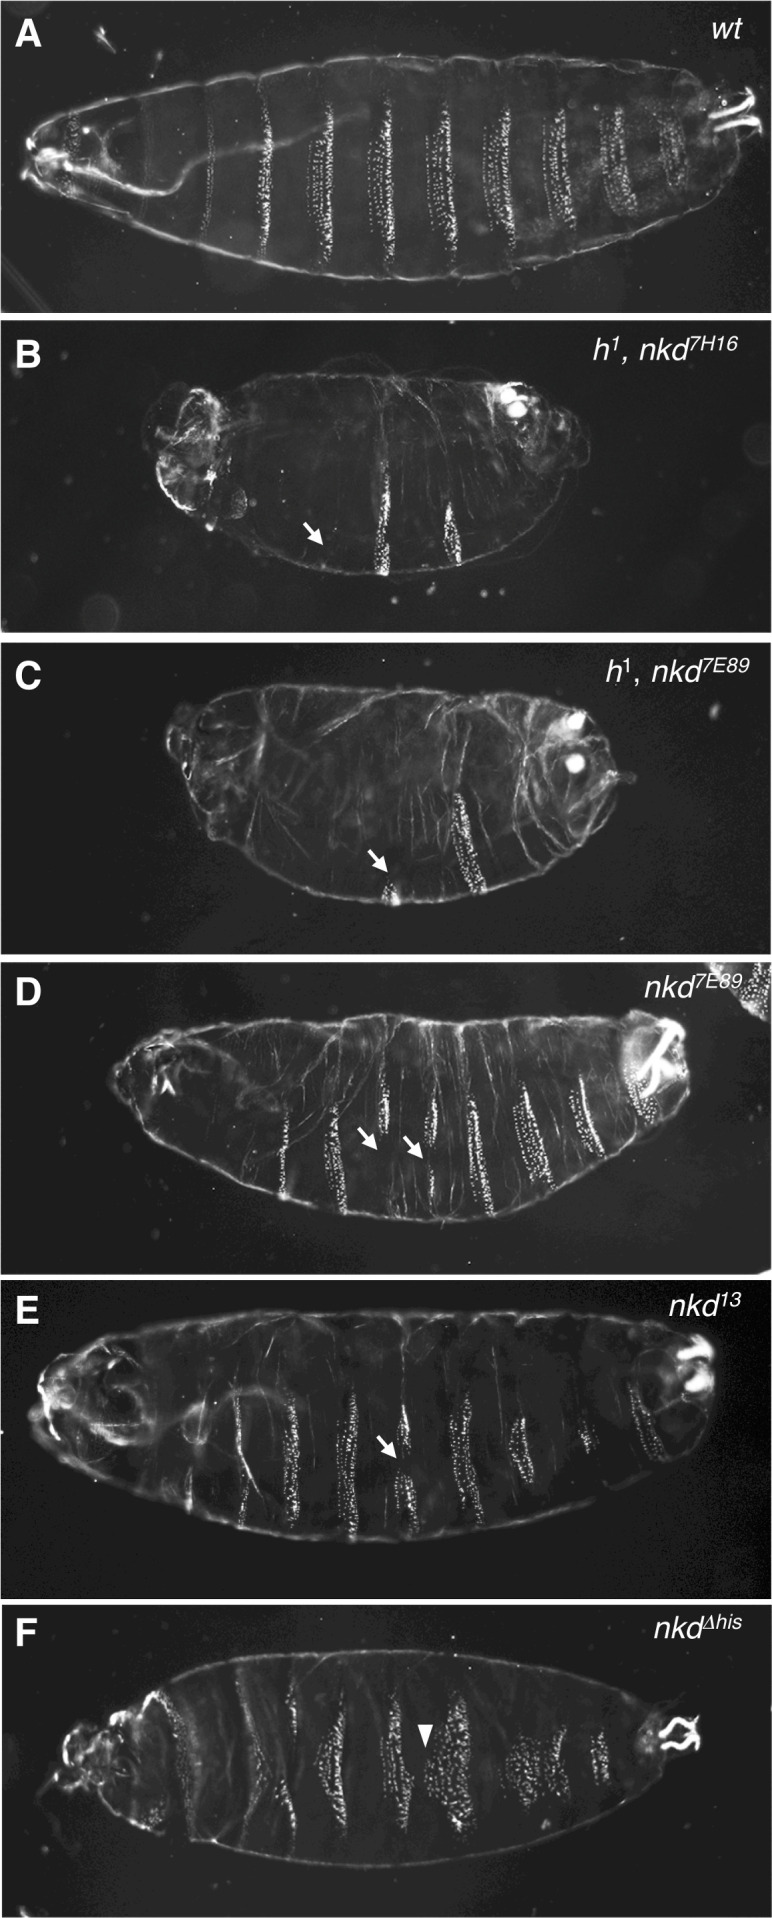
Allele-dependent Wg signaling defects in nkd mutant Drosophila embryos.Dark-field images of ventral cuticles of (A) wt and (B–F) homozygous mutant embryos, as indicated in panels (nkd7H16, nkd7E98, pre-existing alleles; nkd13, nkdΔhis CRISPR-engineered alleles), showing regions of excess naked cuticle (arrows) signifying ectopic Wg signaling. Note that the ‘near-naked’ phenotype is only seen in embryos bearing h1 (B, C); excess naked cuticle regions are seen infrequently in null-mutant embryos without h1 (D, E), or not at all in nkdΔhis embryos bearing a HisC deletion (F) whose most penetrant phenotype are excess small denticles (arrowheads) signifying reduced Wg signaling.Figure 6—source data 1.Oligonucleotides used for Drosophila CRISPR engineering and confirmation of lesions.